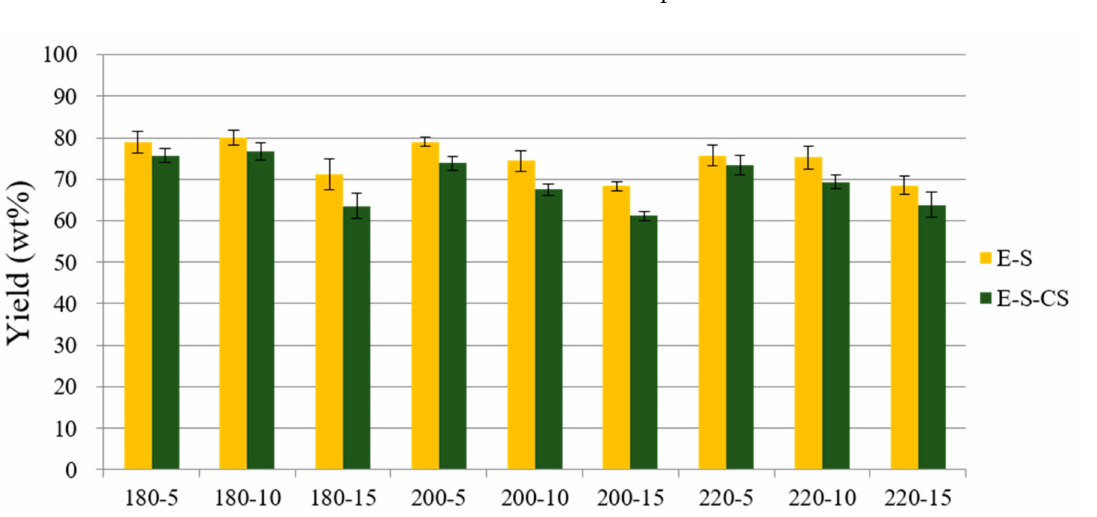
Figure 2. Yields of the solid fractions from steam explosion and organosolv treatment of EFB under di ff erent temperatures and residence